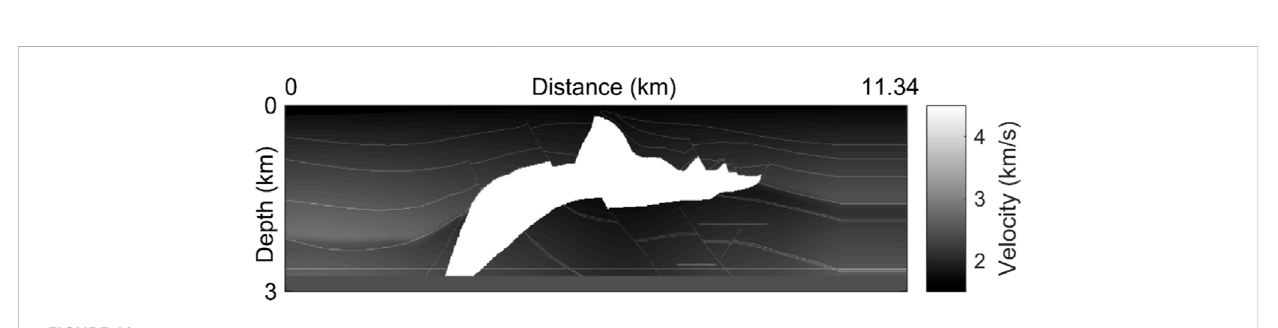
FIGURE 11 Acoustic velocity structure of the SEG/EAGE model.